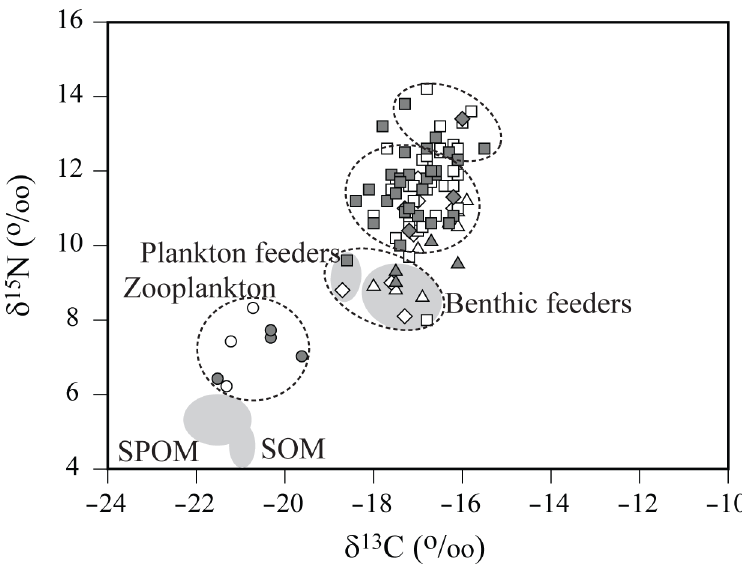
Fig 8. Dual plots of mean δ 13 C and δ 15 N values for zooplankton, other invertebrates, and fish in spring (white) and fall (gray) in offshore habitats. The groups of taxa were clustered according to the result of hierarchical cluster analysis (see details in Methods). Circle, zooplankton; triangle, arthropods; diamond, mollusks; square, fish. Grey ellipses represent suspended particulate organic matter (SPOM) and sedimentary organic matter (SOM). Species name and isotope data are given in S1